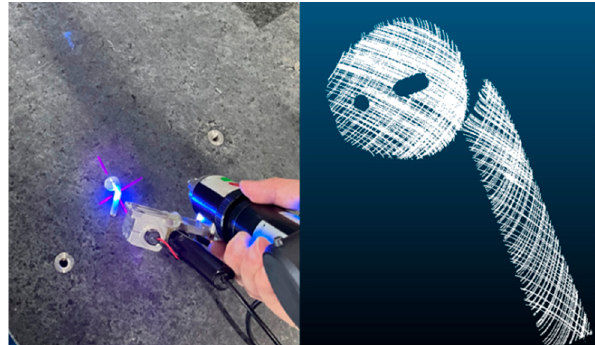
Figure 13. Air pod scanning result.